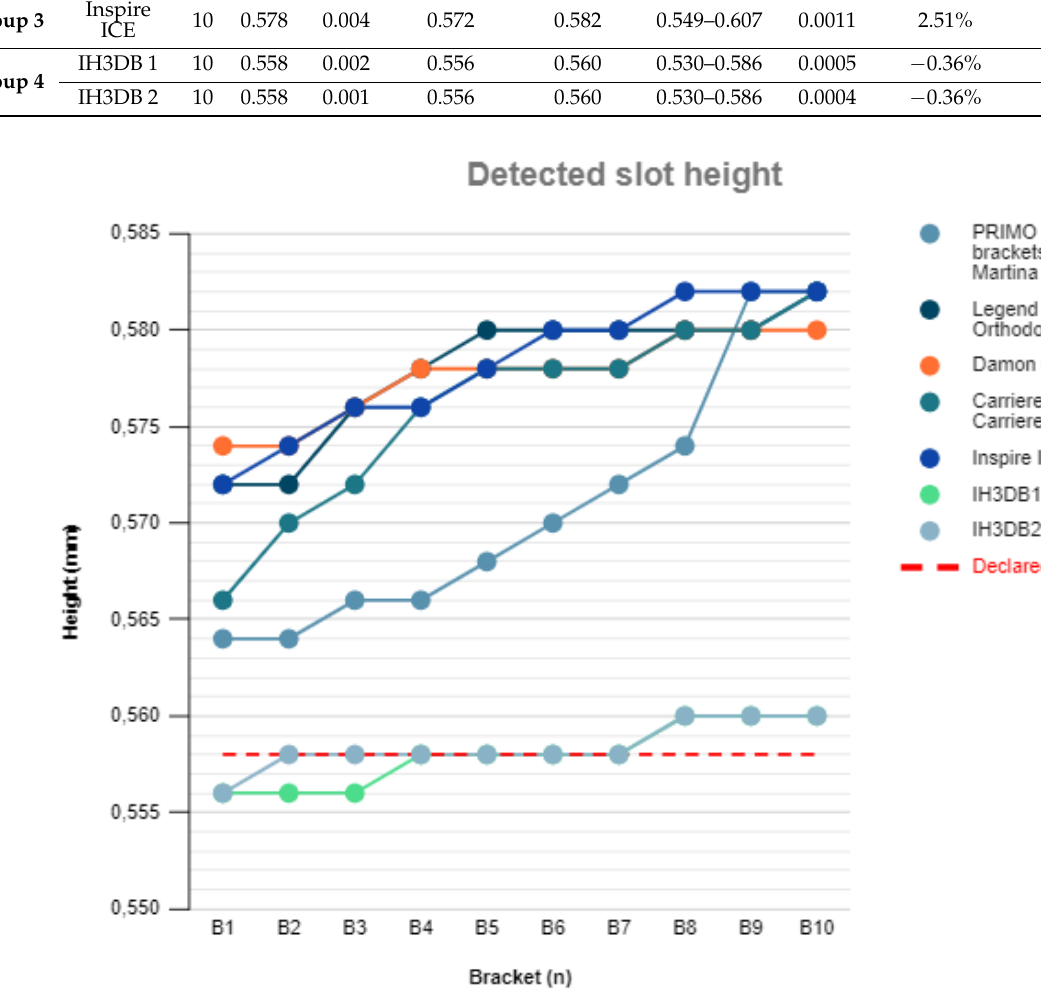
Figure 3. Accuracy of slot height in the various groups.